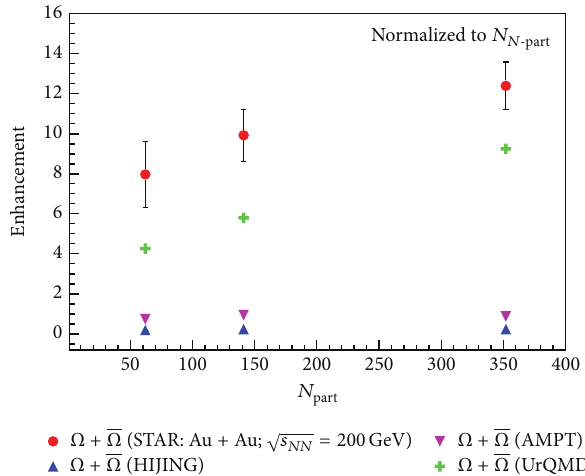
Figure 2: 𝑁 𝑁 -normalized enhancements of (a) Ξ − and (b) Ξ -part are compared with HIJING, AMPT, and UrQMD models at midrapidity.